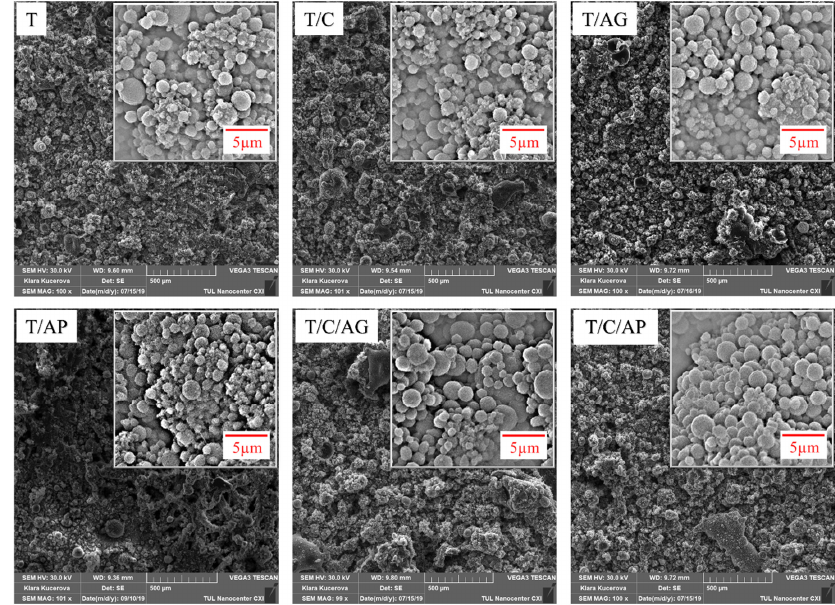
Figure 3. SEMs of the electro-sprayed materials with low magnification (100×) and high magnification (10,000×).